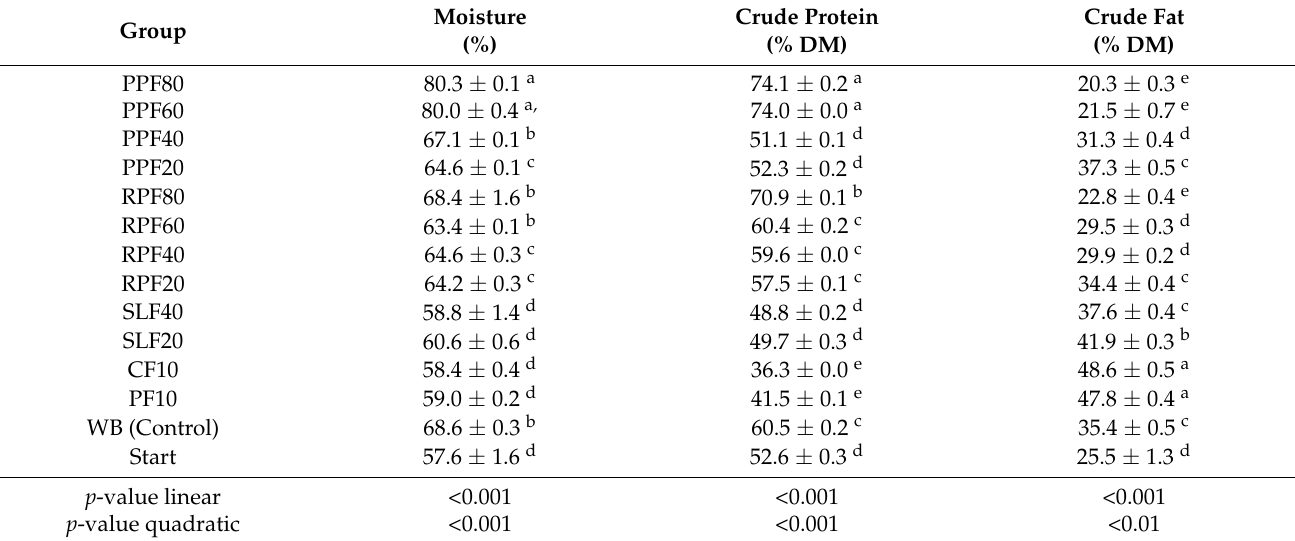
Table 6. Nutritional composition on a dry matter (DM) basis (%) of Tenebrio molitor larvae. Values are given as mean ± standard deviation, n = 3.